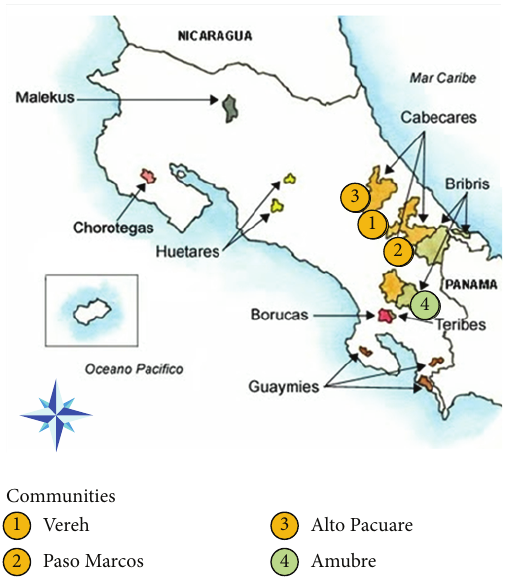
Figure 1: Location of indigenous communities in Costa Rica, show- ing the four sites sampled (taken from http://costarica1.bligoo.com .mx/?page=2 and